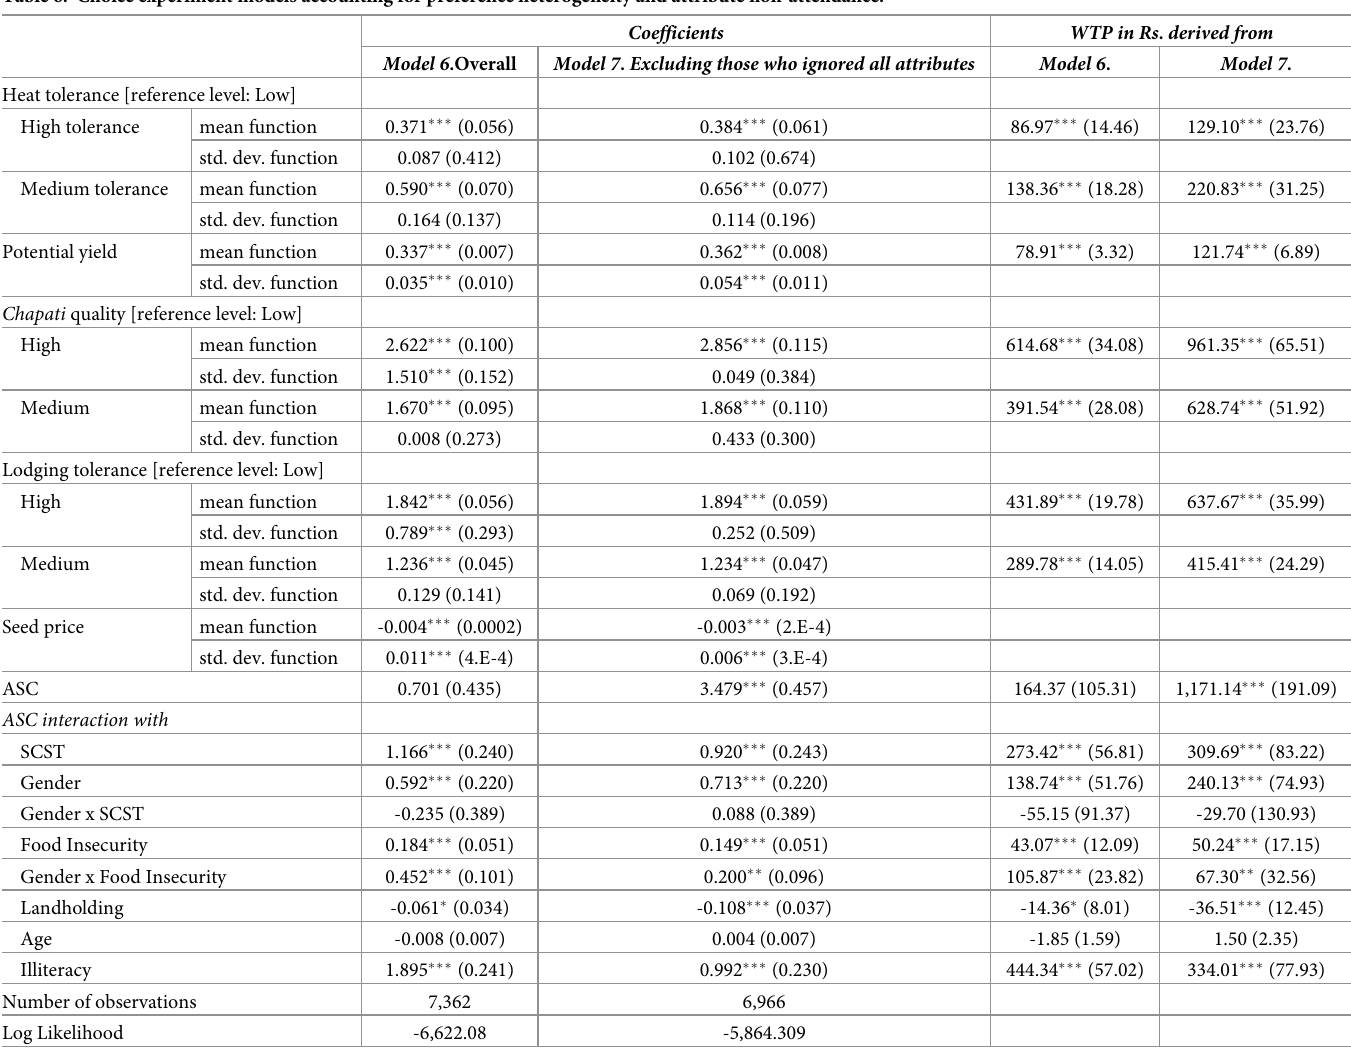
Table 6. Choice experiment models accounting for preference heterogeneity and attribute